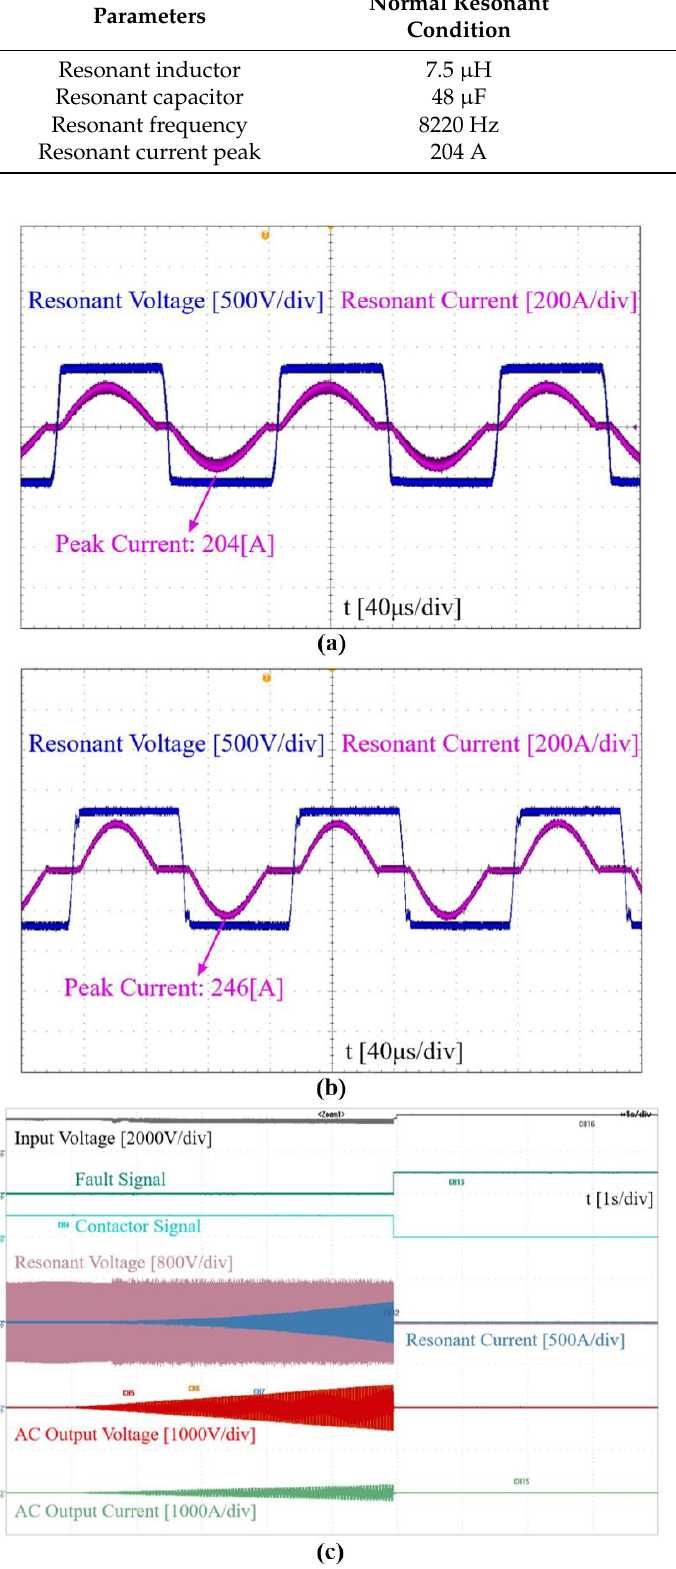
Figure 23. Experimental results of resonant destruction